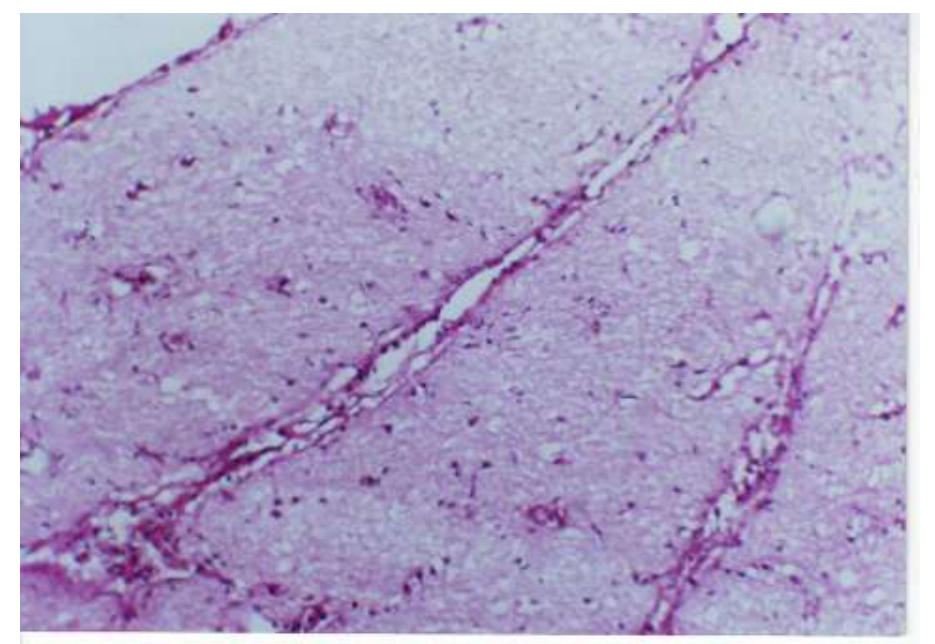
Figure (2): Brain of Mice , 1 st group see:(a) Brain odema ( X20 : H& E stain )